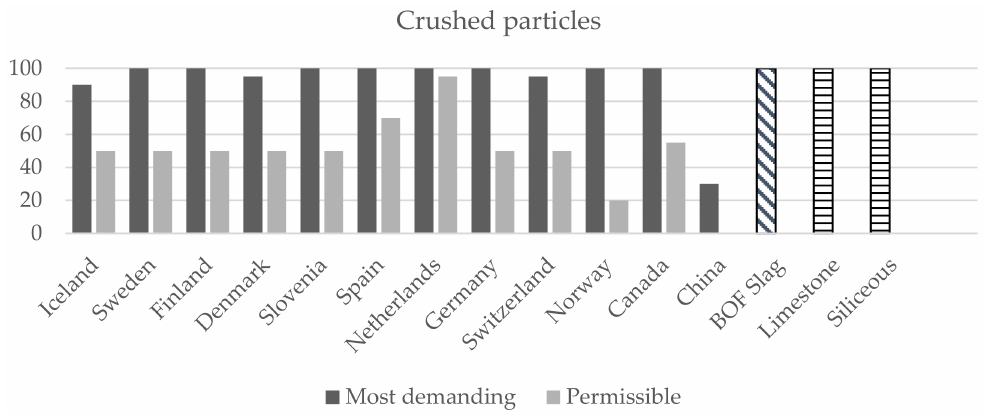
Figure 5. International comparison requirements for aggregates in road construction: Crushed particles.